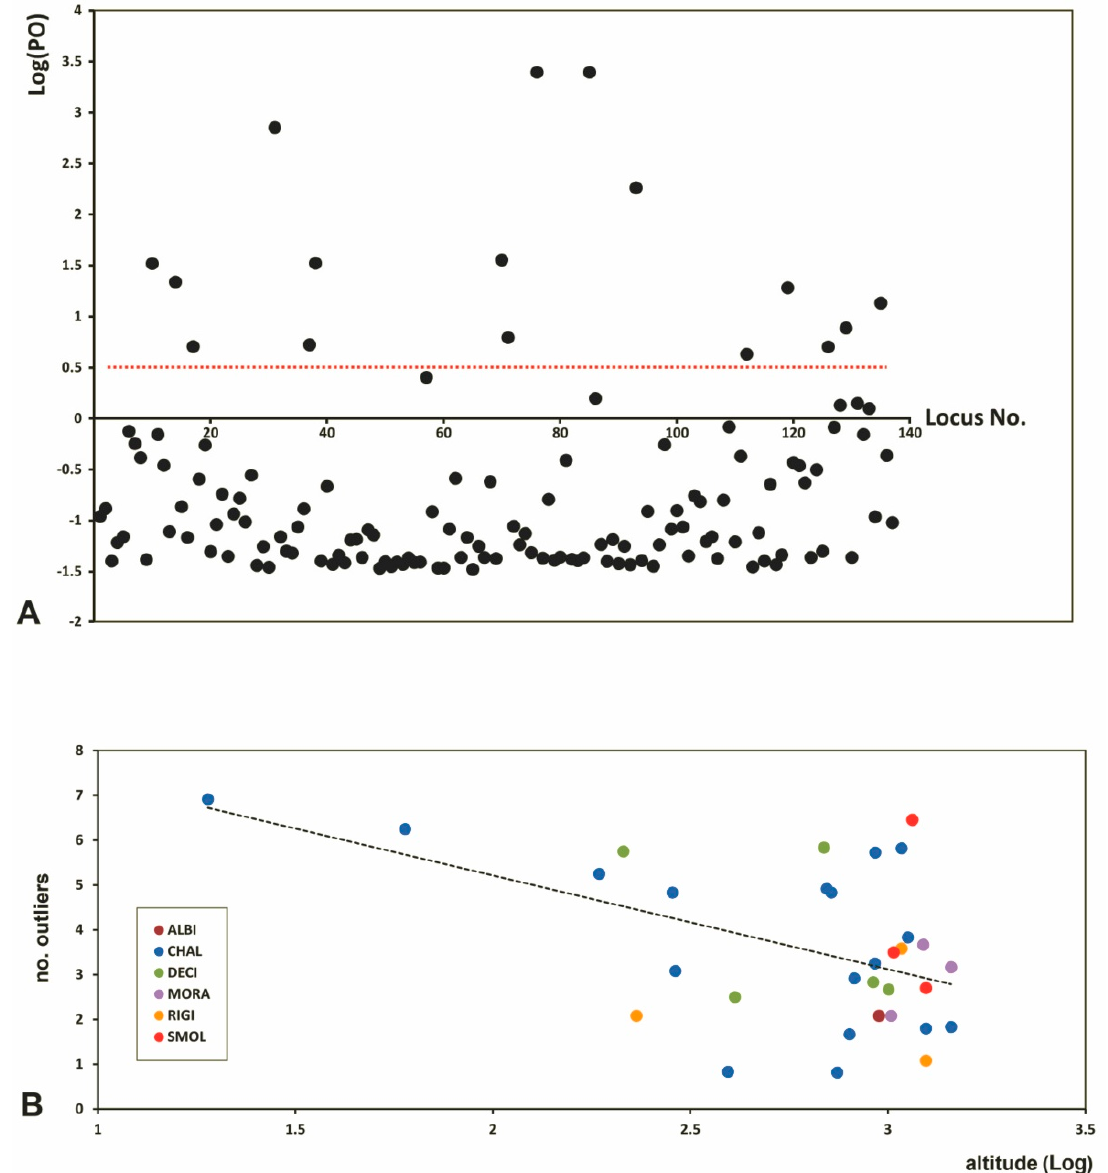
Figure 4. ( A ) Distribution of the 137 loci (black dots) detected by BayeScan analysis of 374 individual samples of Albanian Odontarrhena ; dots that fall over the red threshold line [Log (posterior odds, PO) = 0.5]) are identified as outlier loci. ( B ) variation of the mean number of outliers per population with altitude (log); colours and species names abbreviations follow Figures 1 and 6.